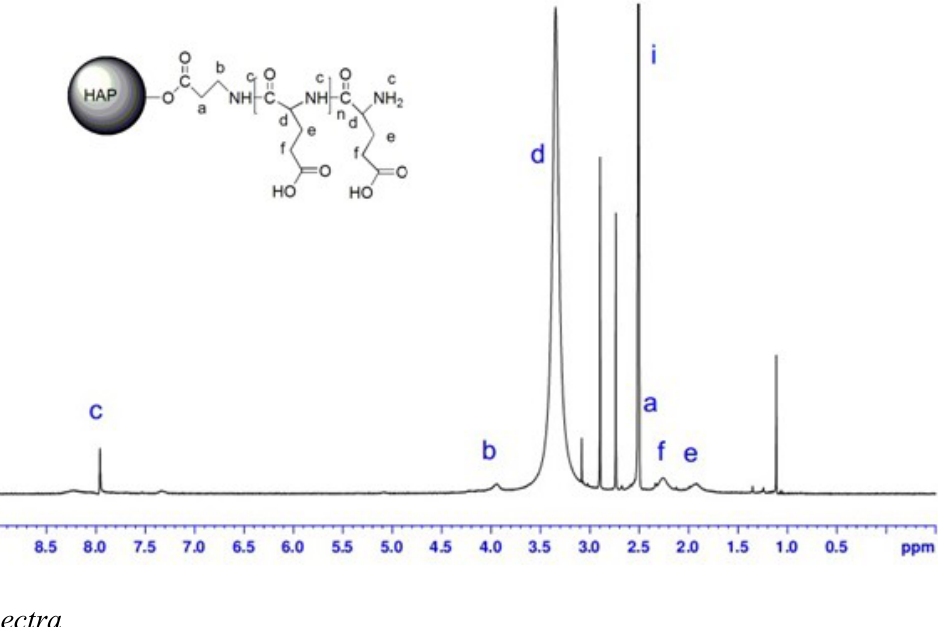
Figure 5. 1 H-NMR spectrum of HAP-100-PLGA in